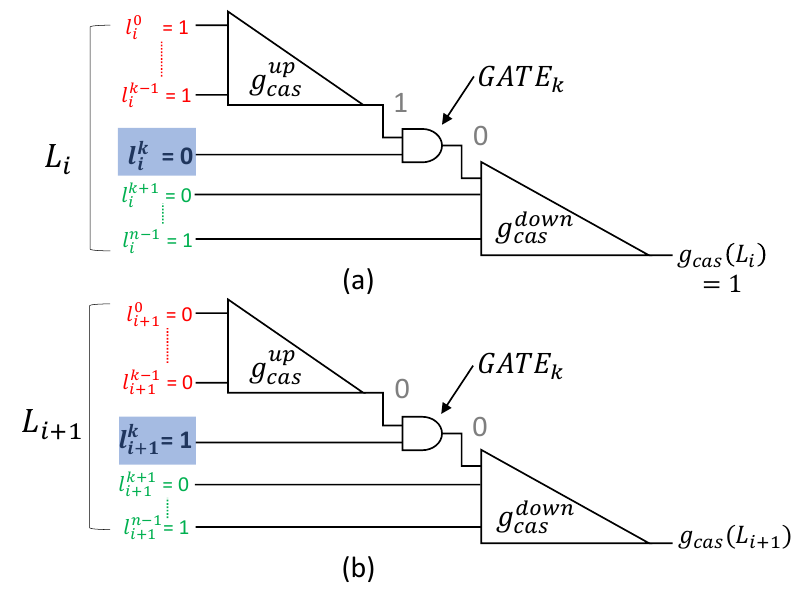
Figure 6: Input vectors L i and L i +1 applied to g